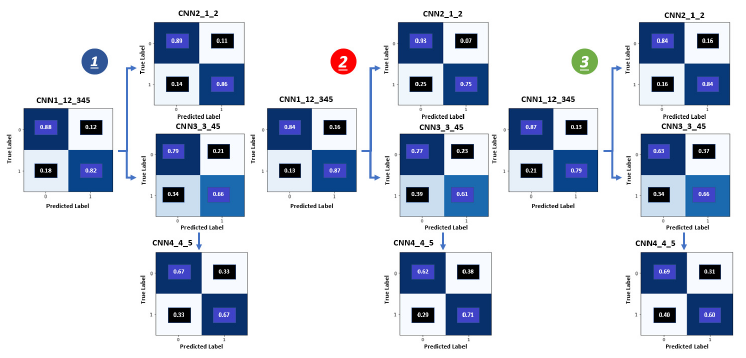
Figure 5. Confusion metrics for grade groups obtained by the proposed system: 1is the first level (100 × 100), 2 is the second level (75 × 75) and the third level (50 × 50).